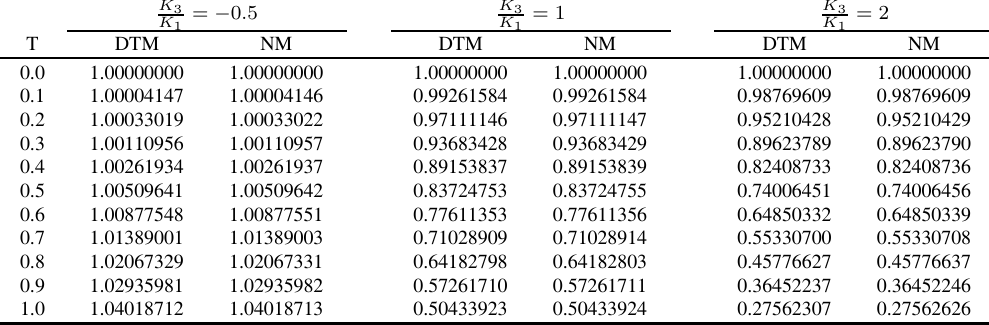
Table 4 when ζ = 0 . 1 , Ω = 0 . 5 and P = 1 1